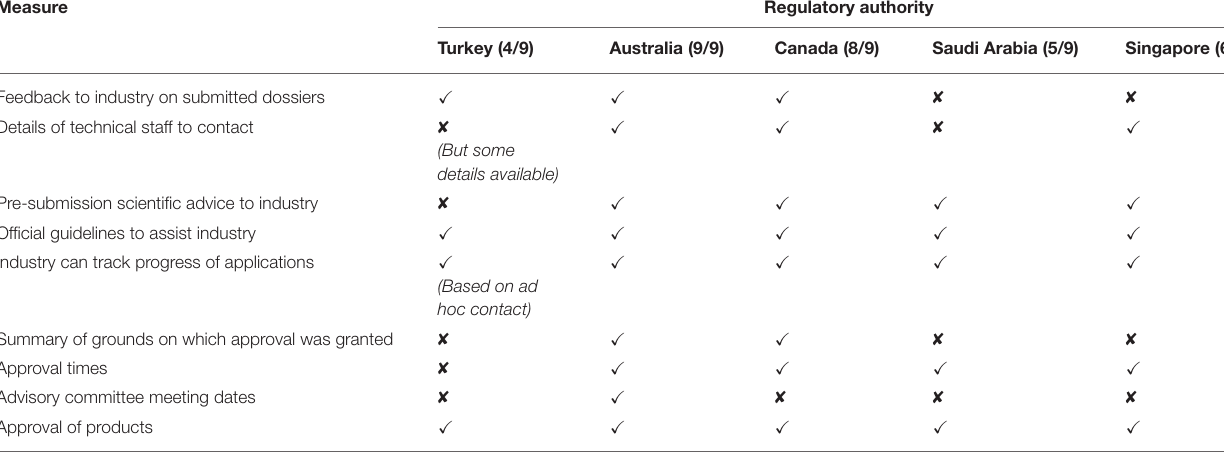
TABLE 3 | Transparency and communication parameters in the five agencies.